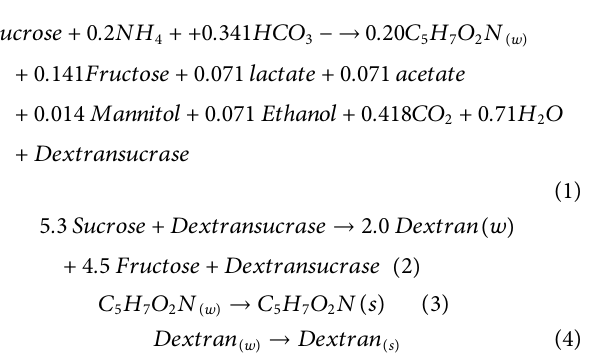
Frontiers in Materials |